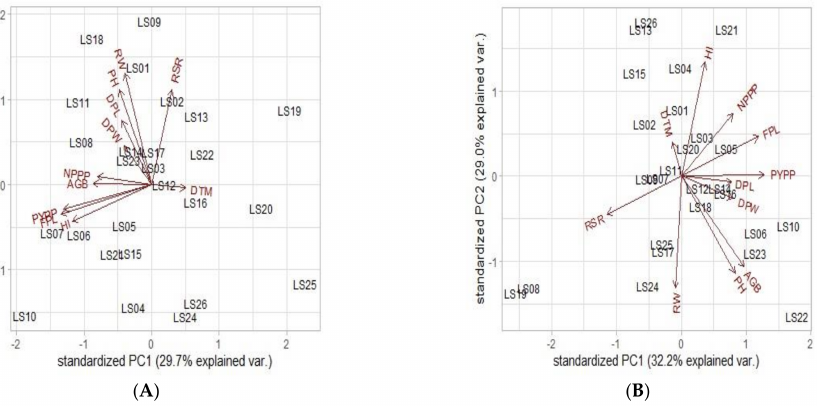
Figure 4. Principal component biplot of PC1 vs. PC2 showing groupings of 26 okra accessions based on phenotypic traits under drought-stressed ( A ) and non-stressed ( B ) conditions. PH: plant